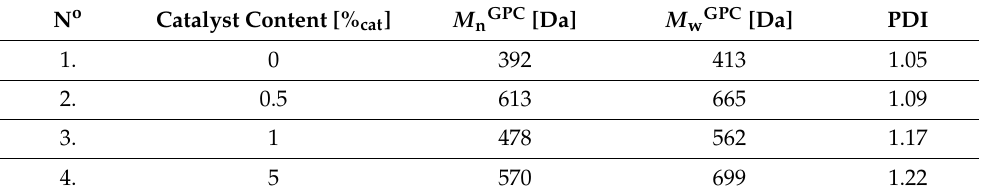
Table 2. The molecular weight of poly(1,2-ethanediol citrate) pre-polymers was obtained at 140 ◦ C. N